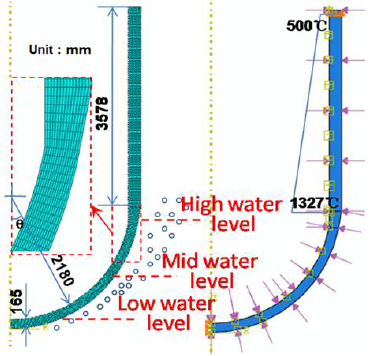
Figure 2. The RPV configuration and its FE-model with applied boundary